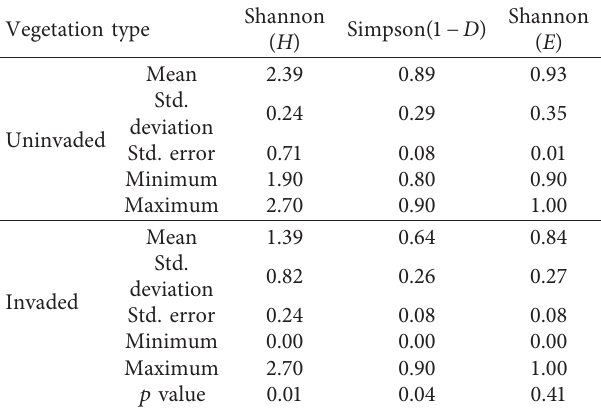
Table 7: Species diversity on study